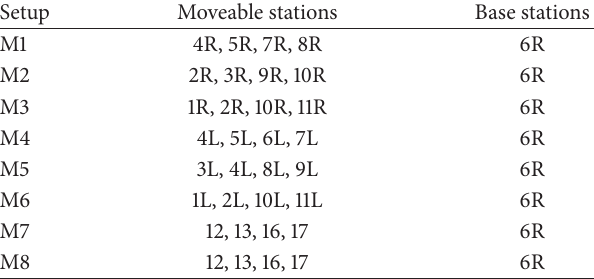
Table 1: Setup of stations during the ambient vibration